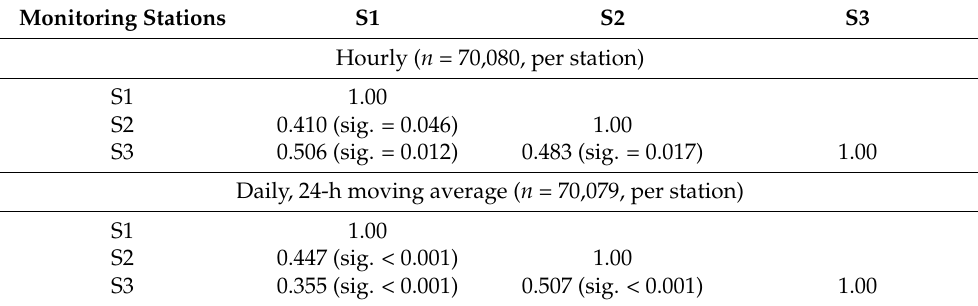
Table 2. Correlations ( rs -Spearman) among monitoring stations for hourly and daily PM 10